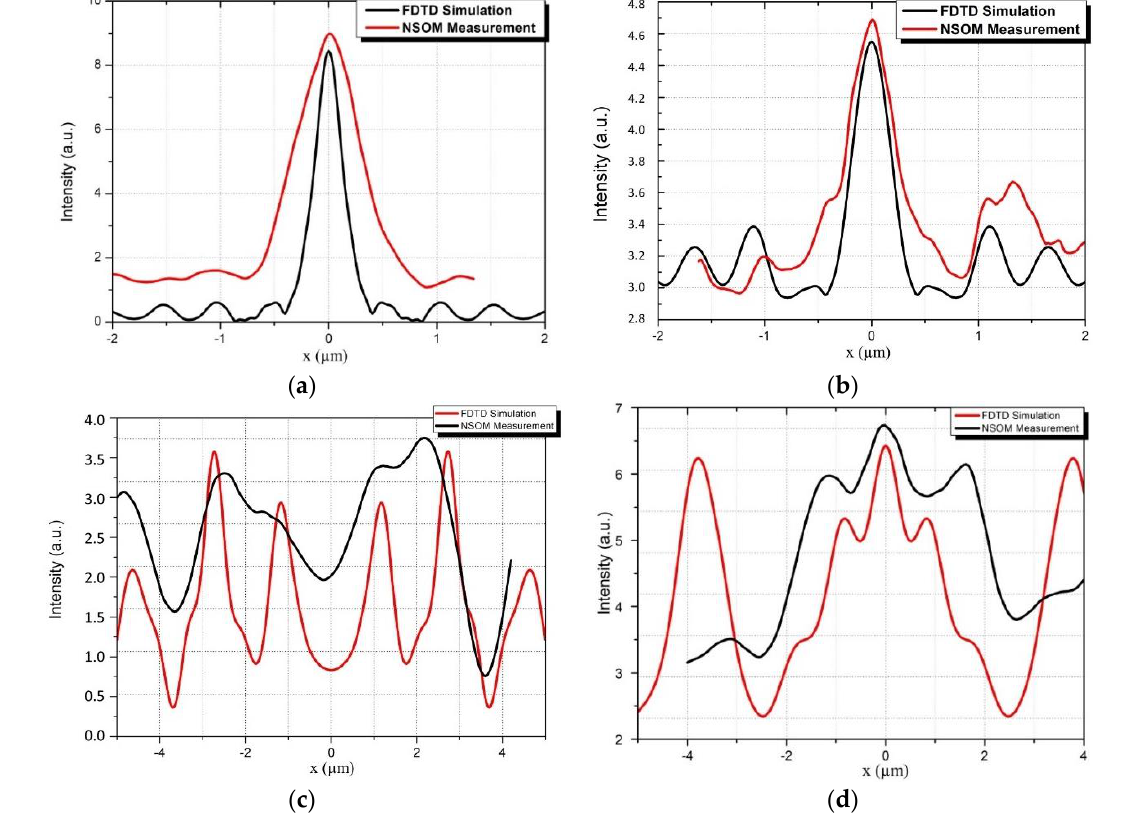
Figure 9. Comparison of simulated and measured electric field intensity profiles at a focal plane located 650 nm above the exit plane illuminated by LED source with wavelength of ( a ) 420 nm, ( b ) 490 nm, ( c ) 625 nm and ( d ) 780 nm.